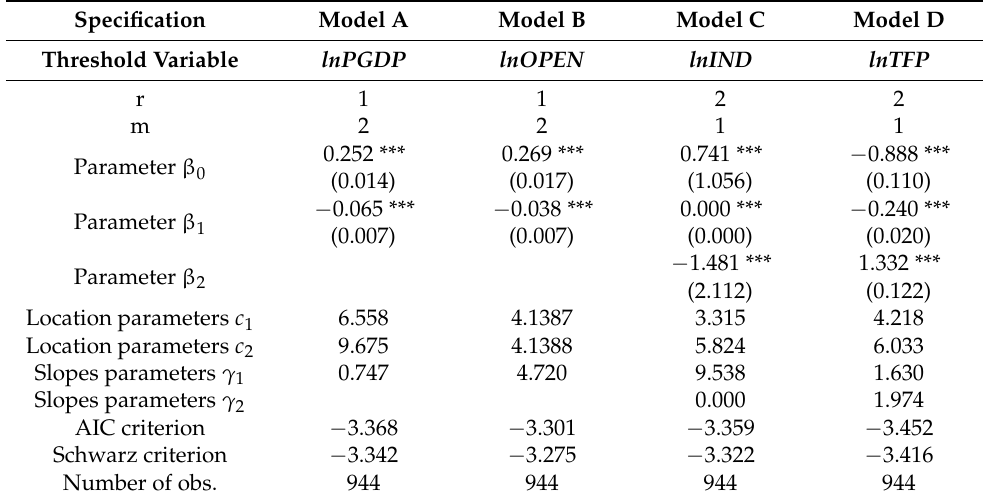
Table 4. Linearity model and PSTR model estimation